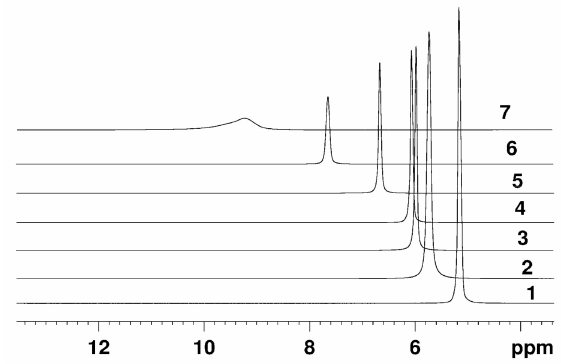
Figure 4. 1 H NMR spectra in acid ionic form of Nafion 117 membrane at different humidity: (1) RH = 95%; (2) RH = 78%; (3) RH = 64%; (4) RH = 58%; (5) RH = 32%; (6) RH = 10%; (7) RH = 0%. Reprinted with permission from [25]. Copyright 2019 Springer Nature.